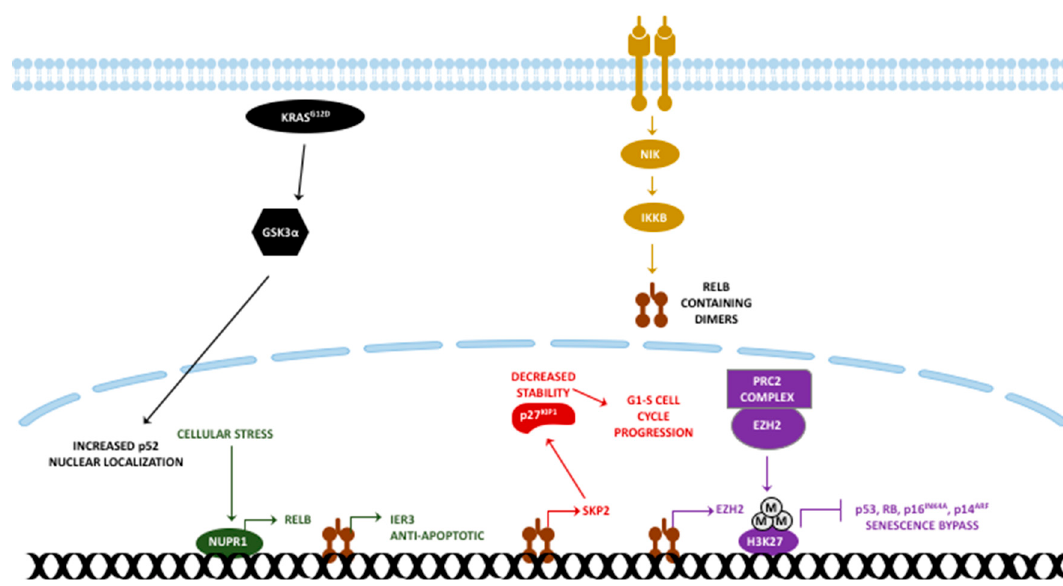
Figure 3. Functions of RelB in pancreatic cancer. Although the EZH2 connection still needs to be confirmed for PDAC, similarities are expected. Each arrow with a different color represents a different signaling axis. M: Methylation.